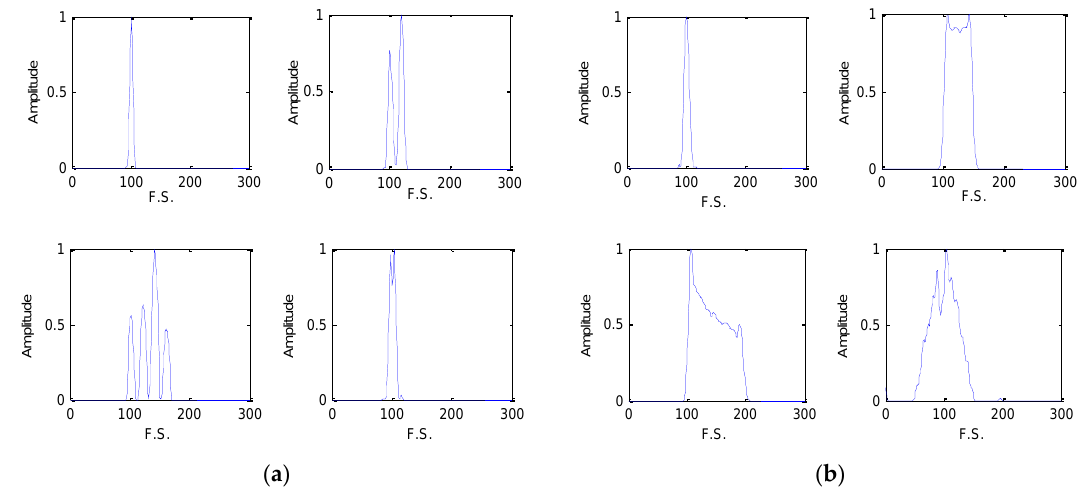
Figure 4. The EC-STFT of eight type radar emitter intra-pulse signals at 20 dB, and the 300 × 1000 image has been sampled into 300 × 100 size, p = 100, q = 300: ( a ) EC-STFT of NS, BFSK, QFSK and BPSK; ( b ) EC-STFT of QPSK, LFM, NLFM and FRANK.